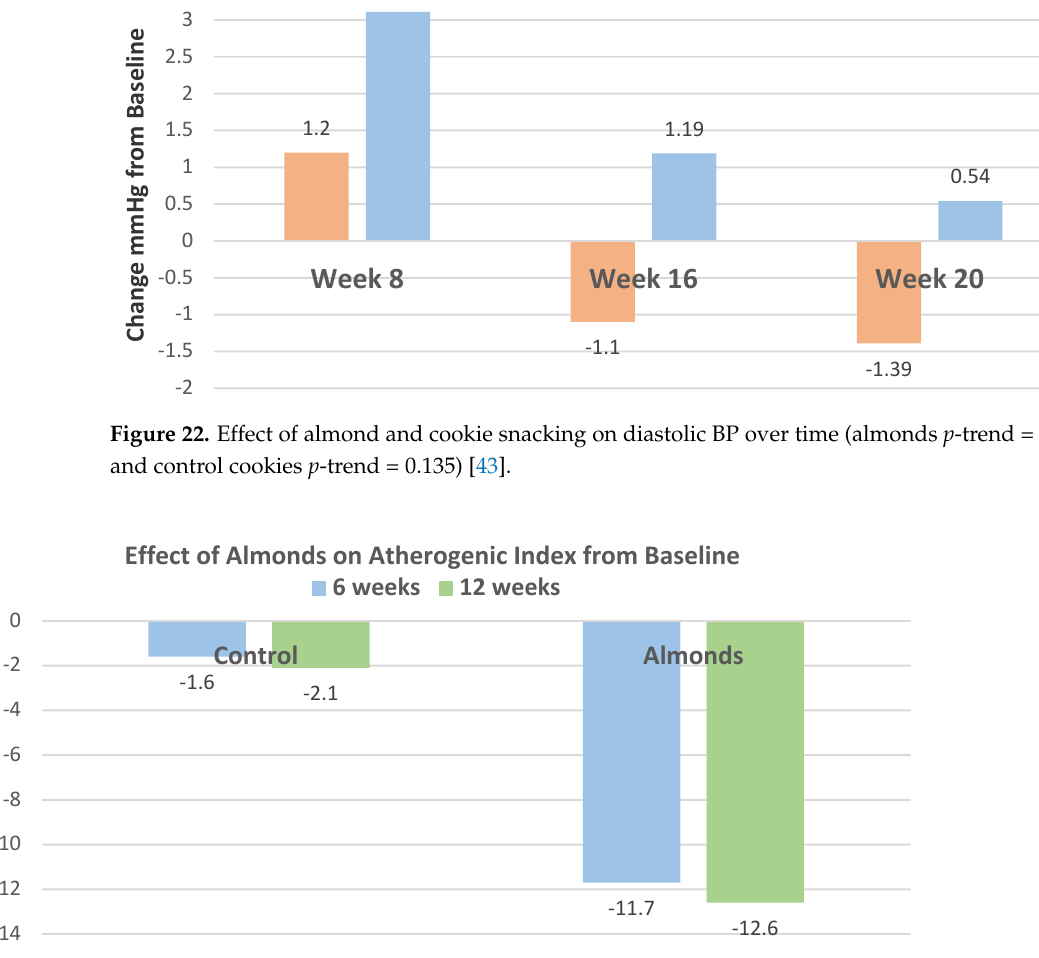
Figure 22. Effect of almond and cookie snacking on diastolic BP over time (almonds p -trend = 0.012 and control cookies p -trend = 0.135) [43].